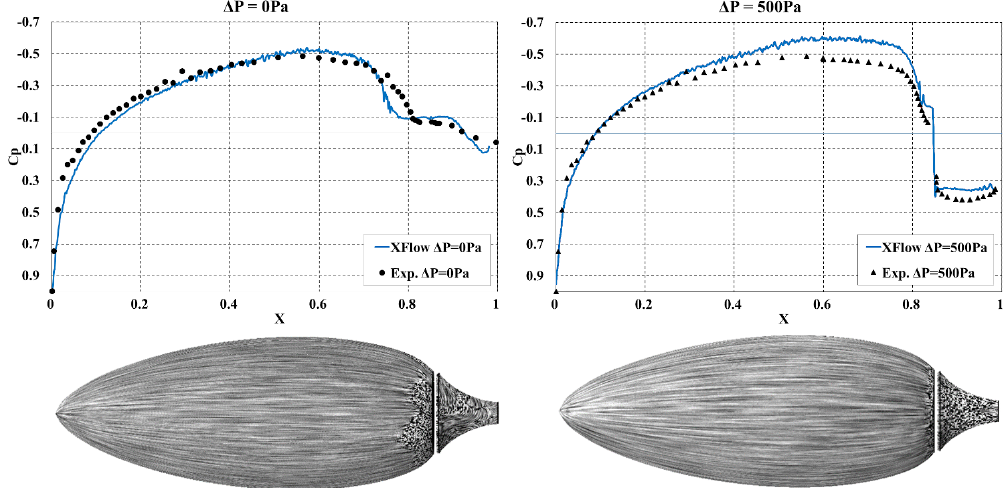
Figure 10. Cp distribution ( top ) and surface flow pattern ( bottom ) with ∆ P = 0 Pa ( left ) and ∆ P = 500 Pa ( right ) at Re = 8.9 · 10 4 (based on the body